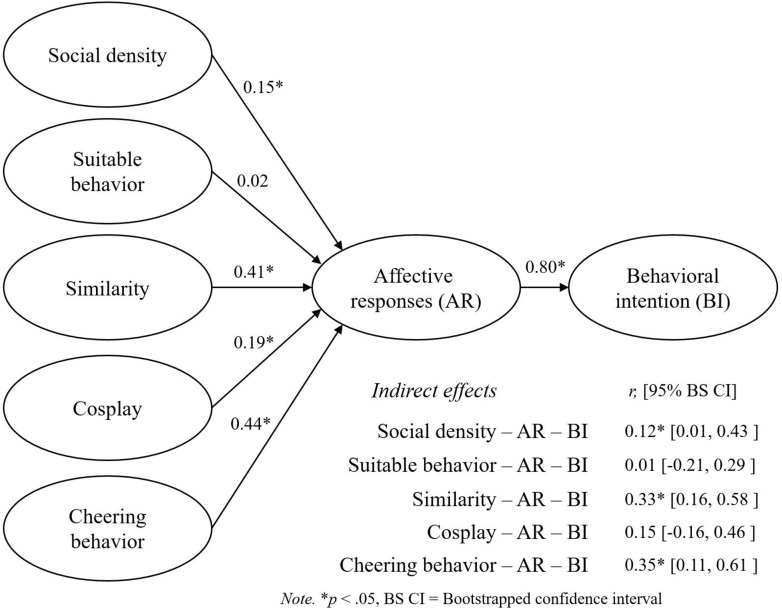
Summary of the results (the second data set, n = 184).